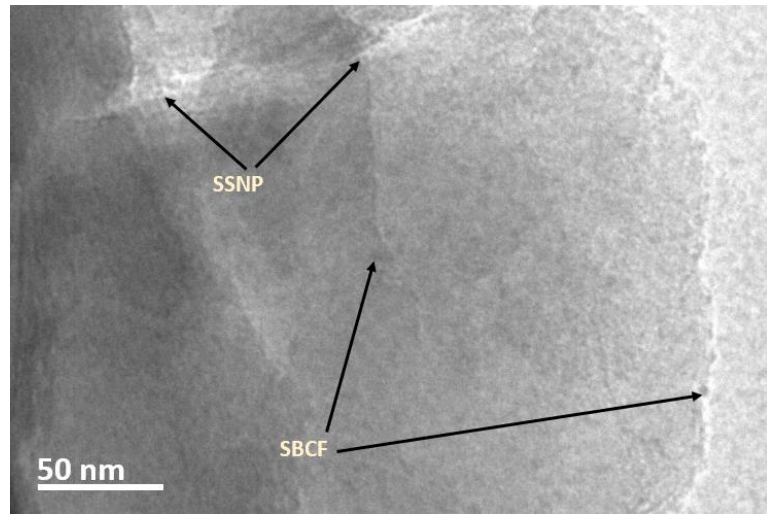
Figure 7. TEM micrograph showing the dispersion of sugarcane bagasse cellulose fibers and snail shell nanoparticles reinforced polylactic acid bioplastic.